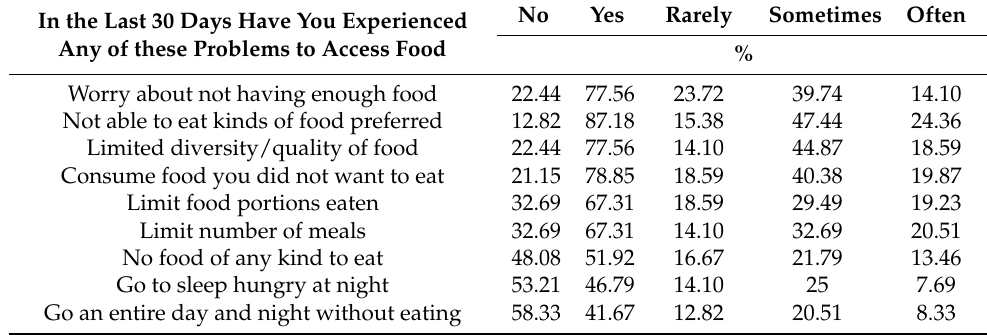
Table 4. Distribution of affirmative responses to items on the HFIAS.